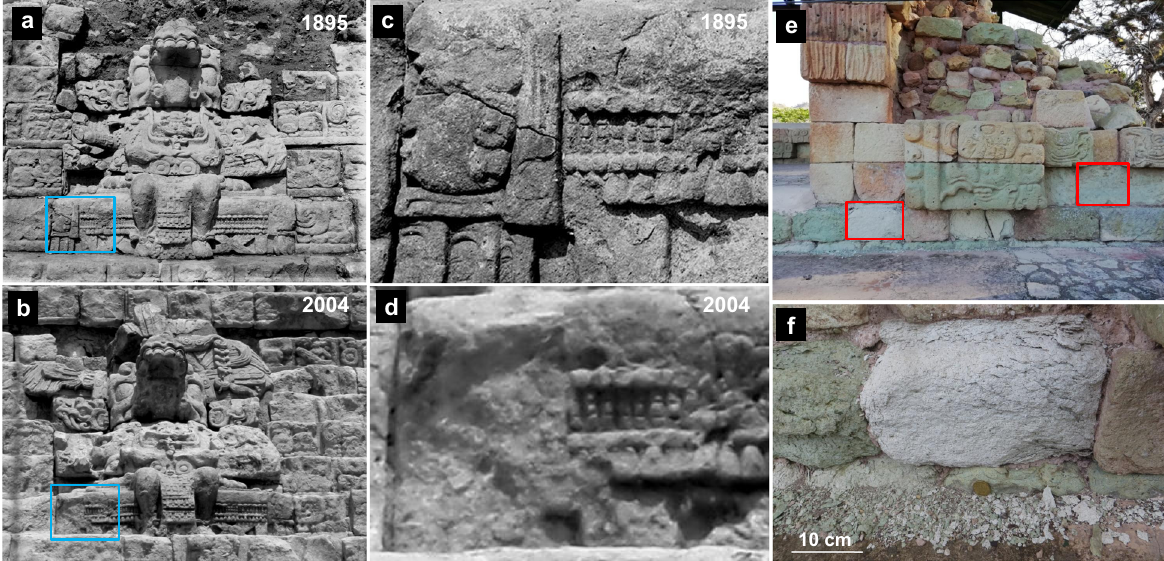
Fig. 1 Decay of Maya tuff stone at Copan. Images of the fi rst seated ruler portrait in the Hieroglyphic Stairway taken after partial reconstruction in 1895 ( a ) and in 2004 ( b ). Signi fi cant surface stone material has been lost leading to the disappearance of relief details as shown by the high magni fi cation image pairs ( c , d ) corresponding to the blue squares in ( a ) and ( b ); ( e ) general view of the area of Structure 10L-18 selected for the fi eld trial application of the bacterial bioconsolidation treatment. The red-squared blocks were treated with the M-3P solution; ( f ) detail of the decay suffered by the tuff stone blocks, resulting in massive fl aking and scaling, and the accumulation of stone debris at the bottom of the wall in Structure 10L-18. Credits: ( a ) Courtesy of the Peabody Museum of Archaeology and Ethnology, Harvard University, PM 2004.24.1865.1; ( b ) Image by Barbara W.